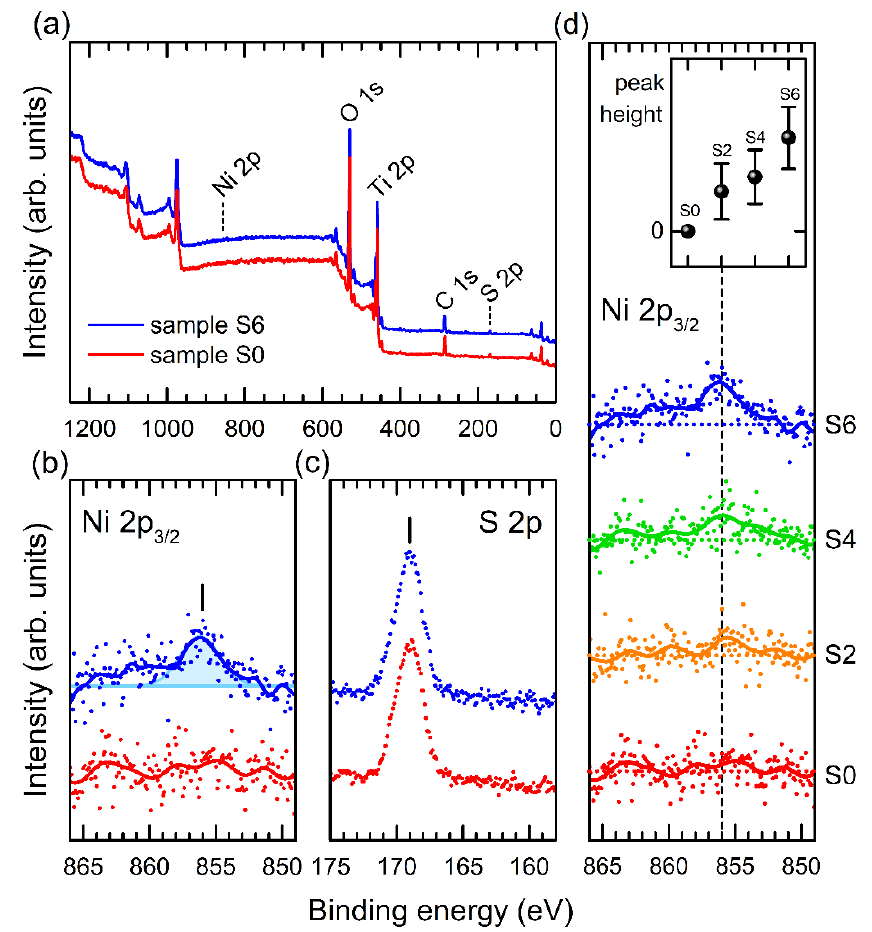
Figure 3. XPS spectra taken from samples S0 (red) and S6 (blue): ( a ) wide scans; ( b , c ) detailed scans of the Ni 2p 3/2 and S 2p binding energy regions. The photoemission signal from Ni is highlighted in panel ( b ) by fitting a peak function to the experimental data. ( d ) XPS spectra taken from samples S0 (red), S2 (orange), S4 (green) and S6 (blue) and Ni peak height as a function of the Ni concentration. The spectra of panels ( b ) and ( d ), shown after the subtraction of a linear background, have been additionally smoothed to enhance the visibility of the Ni line shape. Spectra from different samples are vertically offset for clarity.